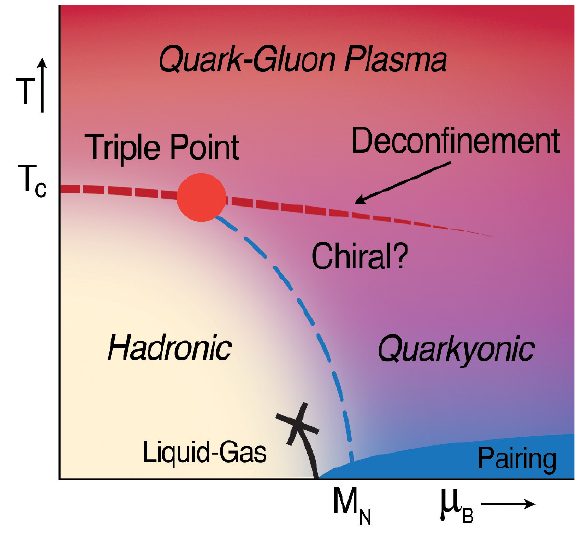
Figure 1. Phase diagram of the nuclear matter. Temperature vs. baryonic chemical potential